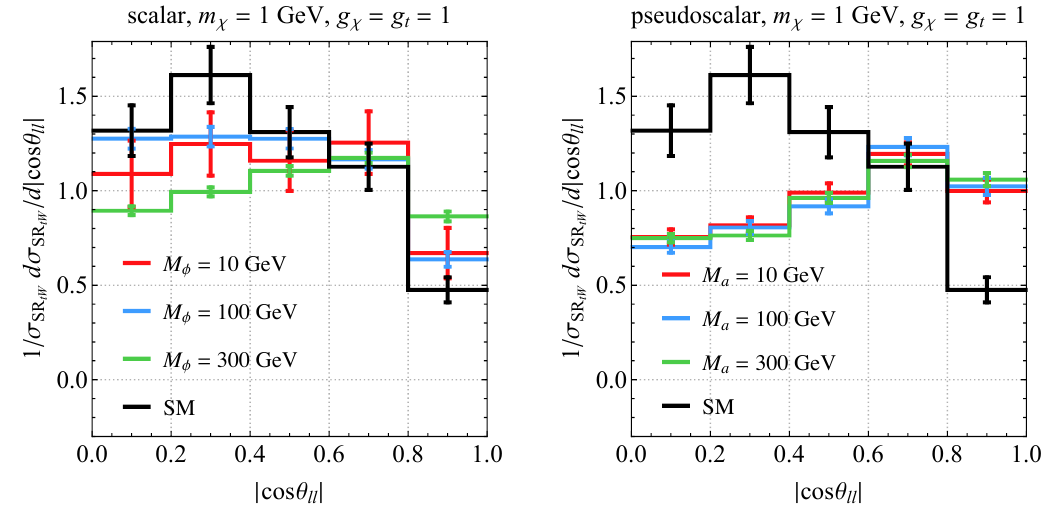
Figure 6 . As (cid:12)gure 4 but combining the dilepton events that arise from both t (cid:22) t + E miss tW + E miss production in spin-0 s -channel DM simpli(cid:12)ed models into a single sample. The shown T error bars represent the statistical errors associated to our MC simulations. For comparison also the SM distribution is